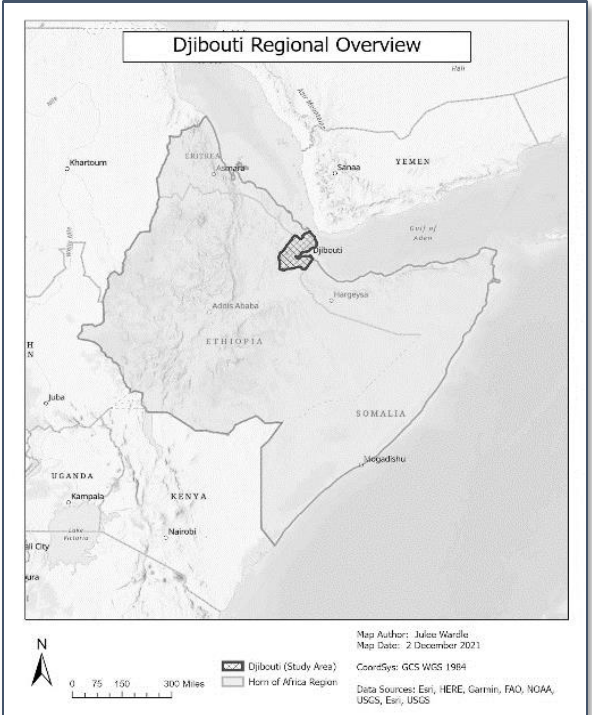
Figure 2. Djibouti’s location in the Horn of Africa. Figure 1. Djibouti’s location in the Horn of